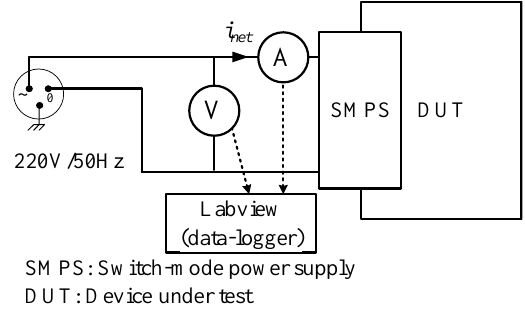
Figure 3. Schematic diagram of the experimental